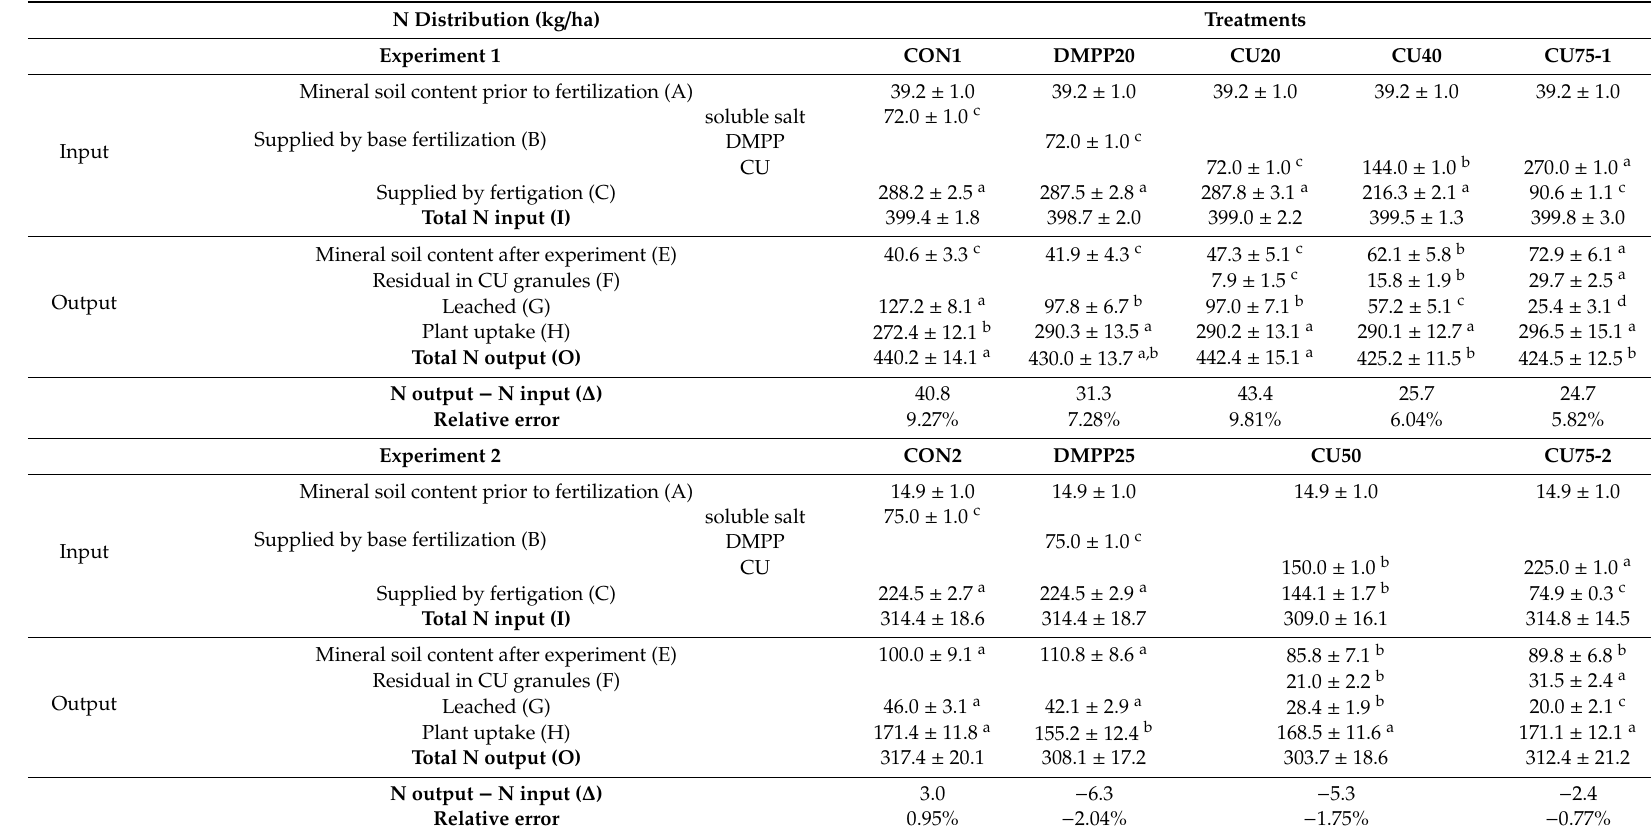
Table 7. Nitrogen balance for di ff erent fertilization strategies in the three